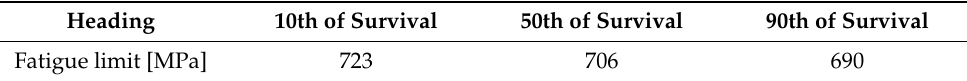
Table 7. Fatigue limits reached by nitrided specimens after staircase fatigue test.